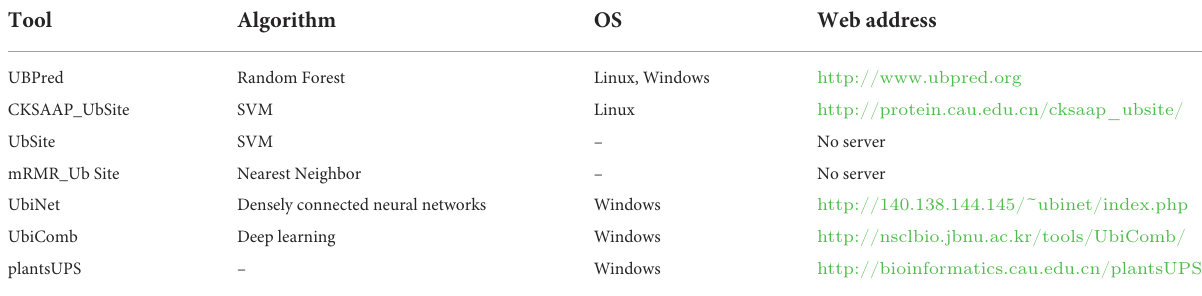
TABLE 2 Prediction and analysis tools for ubiquitination sites.